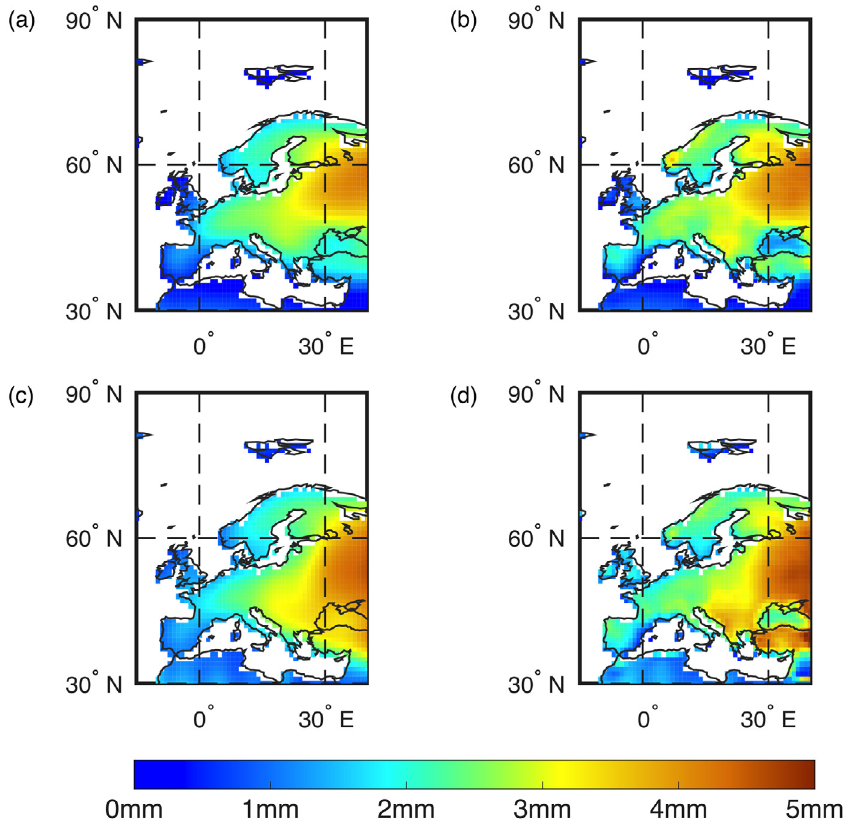
Figure 8. Gridded estimates of annual amplitudes of vertical displacements before and after restoring. The estimates are derived from: (a) GLDAS-NOAH with Stokes coefficients truncation at degree 60 and 300 km Gaussian smoothing; (b) GLDAS-NOAH with Stokes coefficients truncation at degree 180; (c) GRACE GSM products with Stokes coefficients truncation at degree 60 and 300 km Gaussian smoothing; (d) restored annual amplitudes of GRACE-derived vertical